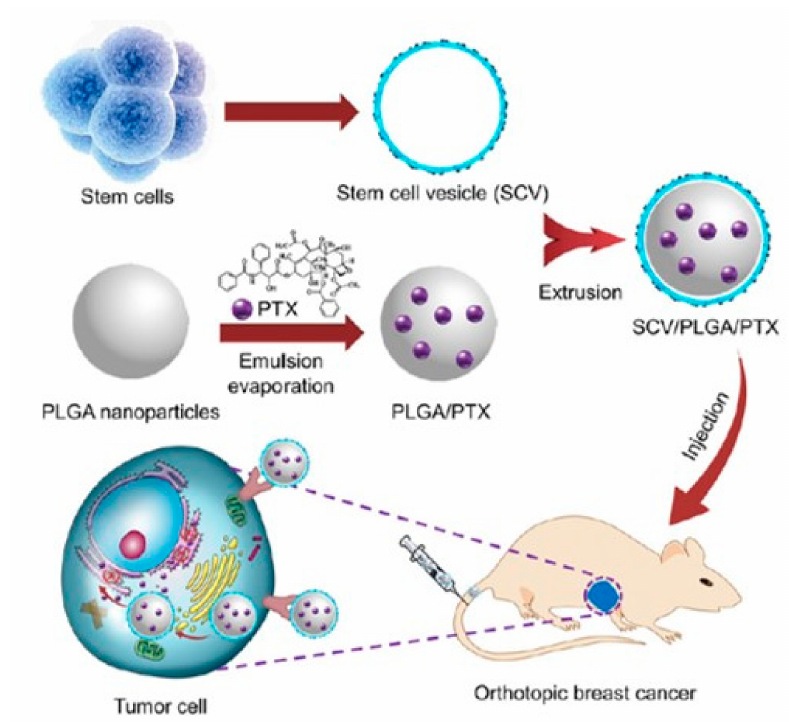
Figure 5. Schematization of PLGA NPs loaded with paclitaxel (PTX) covered with stem cell membranes and their mechanism of tumor target delivery in orthotopic breast cancer in mouse. Reproduced with permission from Ref.